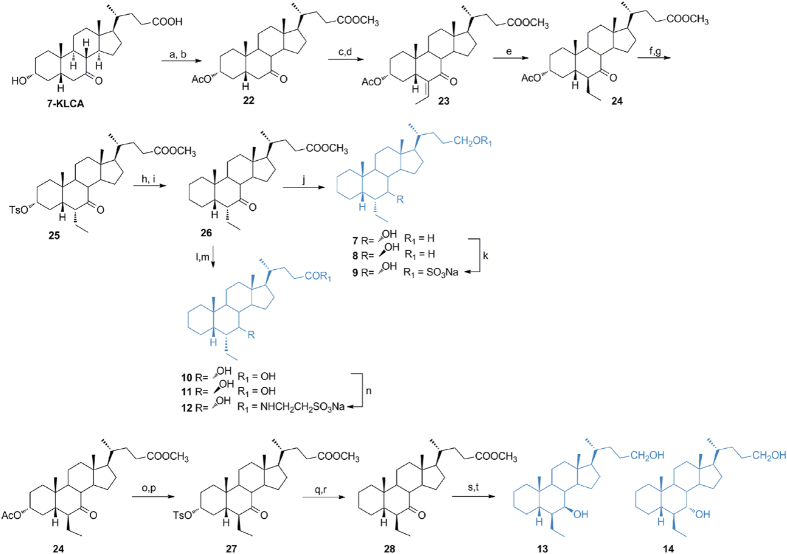
Preparation of 3-deoxy-6-ethylchenocholane derivatives (subset A).Reagents and conditions: (a) p-TsOH, MeOH dry; (b) acetic anhydride, pyridine, 84% yield over two steps; (c) DIPA, n-BuLi, TMSCl, TEA dry, THF dry −78 °C; (d) acetaldehyde, BF3(OEt)2, CH2Cl2, −60 °C, 80% over two steps; (e) H2, Pd(OH)2, THF/MeOH 1:1, quantitative yield; (f) MeONa, MeOH; g) p-TsCl, pyridine, quantitative yield over two steps; (h) LiBr, Li2CO3, DMF, reflux, (i) H2, Pd(OH)2, THF/MeOH 1:1, room temperature, 88% over two steps; (j) LiBH4, MeOH dry, THF, 0 °C, 77%; (k) Et3N.SO3, DMF, 95 °C; (l) NaOH, MeOH:H2O 1:1 v/v, 98%; (m) LiBH4, MeOH dry, THF, 0 °C, 83%; (n) DMT-MM, Et3N, taurine, DMF dry; (o) MeONa, MeOH; (p) p-TsCl, pyridine, quantitative yield over two steps; (q) LiBr, Li2CO3, DMF, reflux; (r) H2, Pd(OH)2, THF/MeOH 1:1, room temperature, 94% over two steps; (s) NaBH4, MeOH; (t) LiBH4, MeOH dry, THF, 0 °C, 78% over two steps.